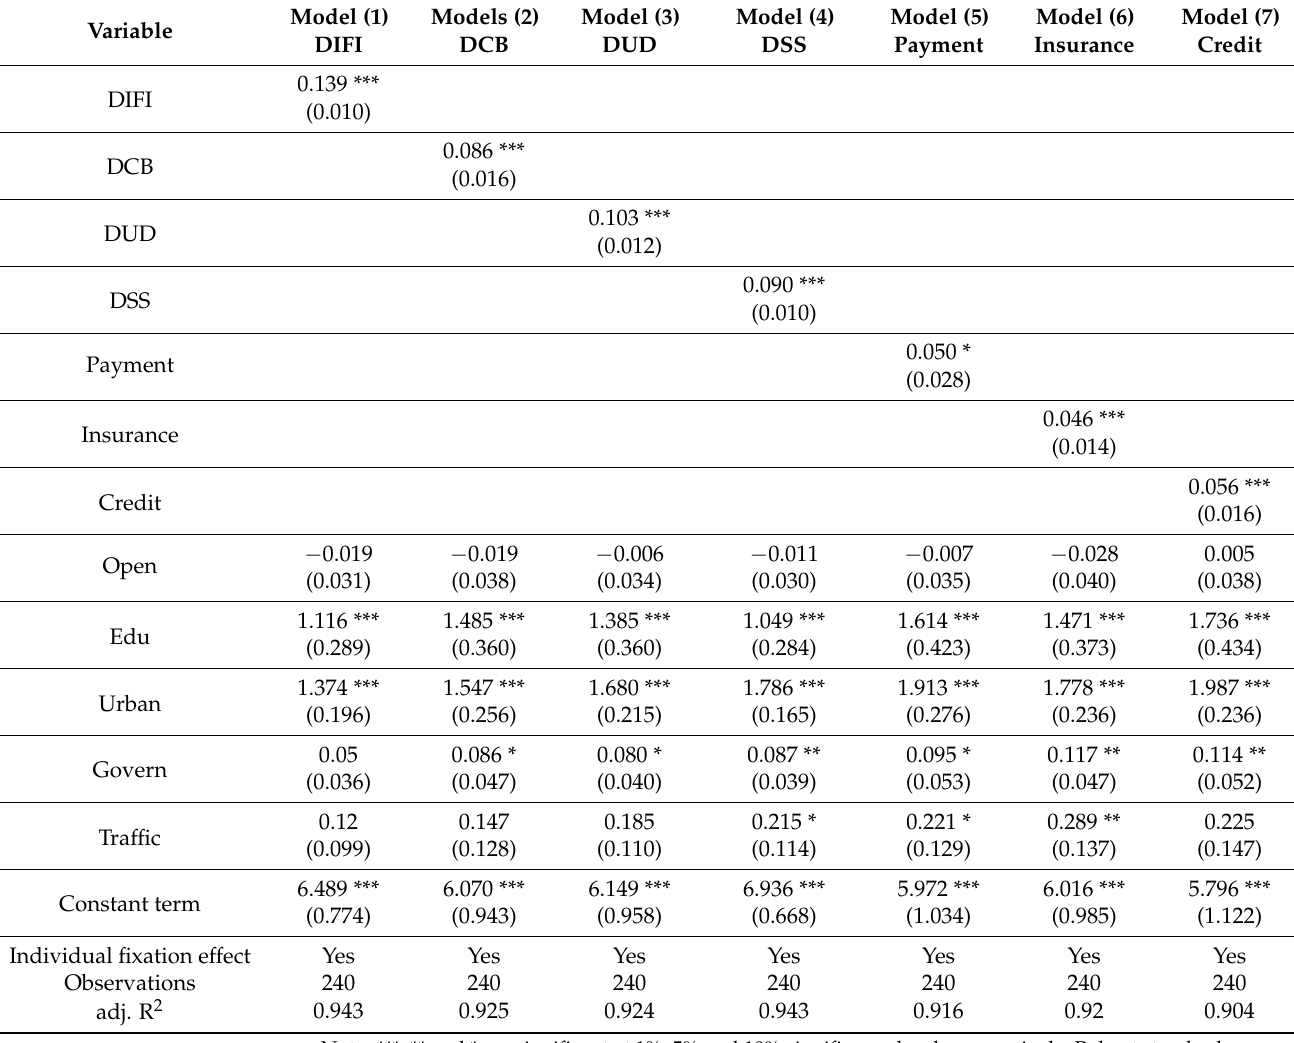
Table 2. DIFI and its sub-indicators on the regression results of per capita disposable